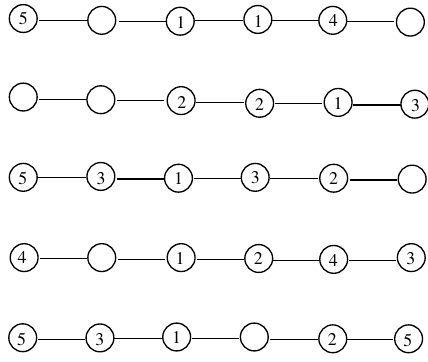
Figure 7: Antiregular dominating labelings of P